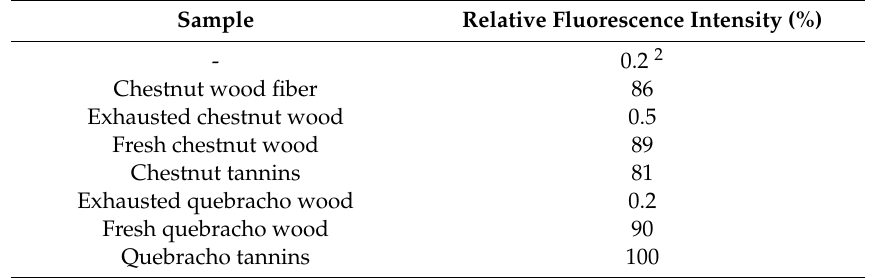
Table 3. Activity of tannins and wood samples in the oxygen radical antioxidant capacity (ORAC) assay. 1.